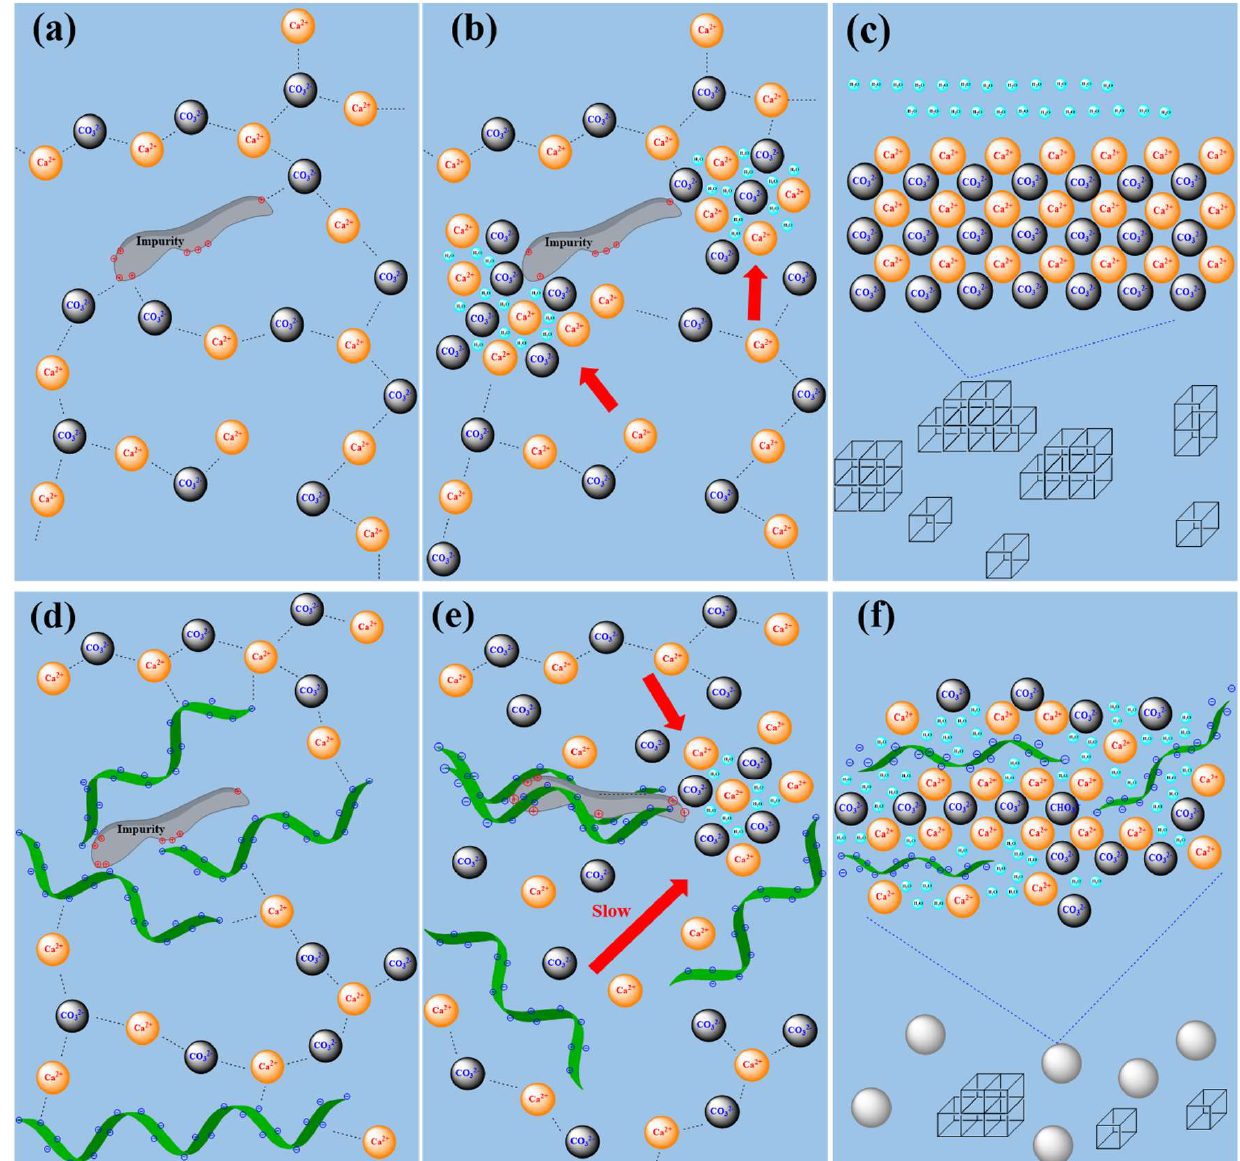
Figure 11. The schematic diagram of multi-stage nucleation. Ionic liquid polymer collapse and dehydration in the absence of PASP ( a – c ); in the presence of PASP ( d – f ).